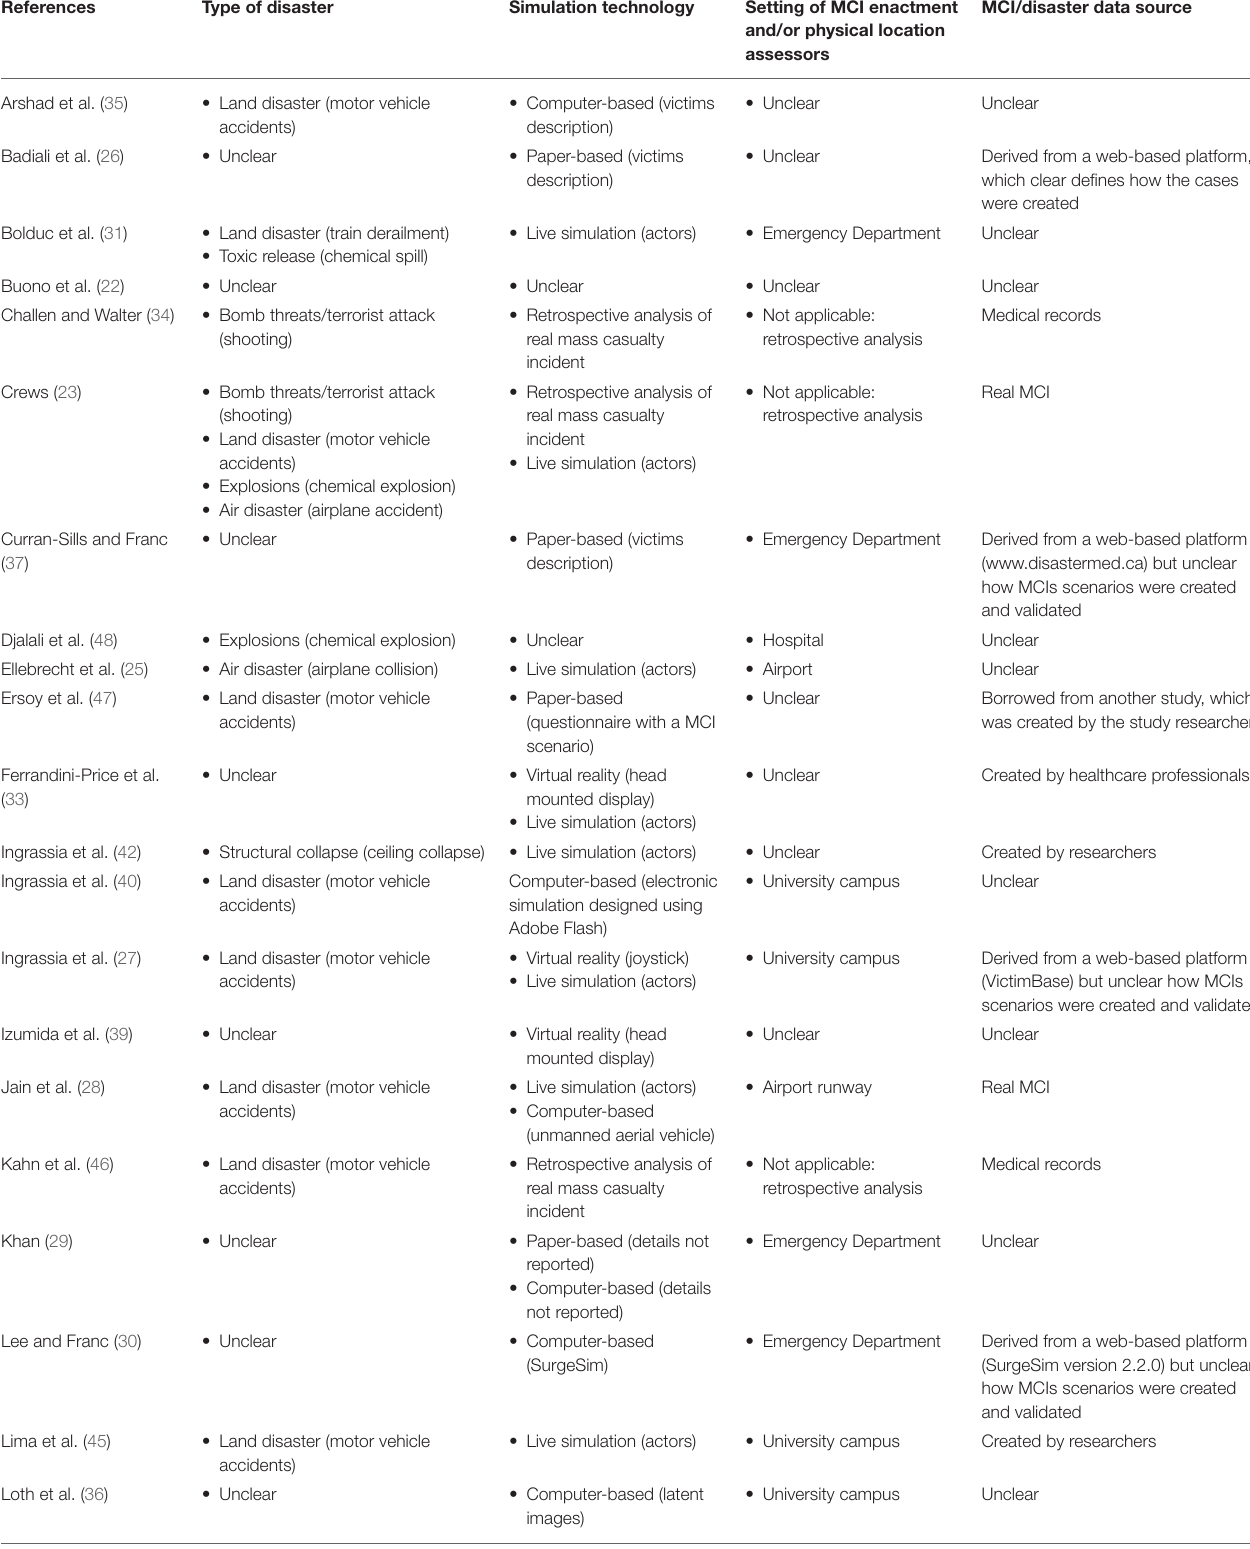
TABLE 3 | Typology of